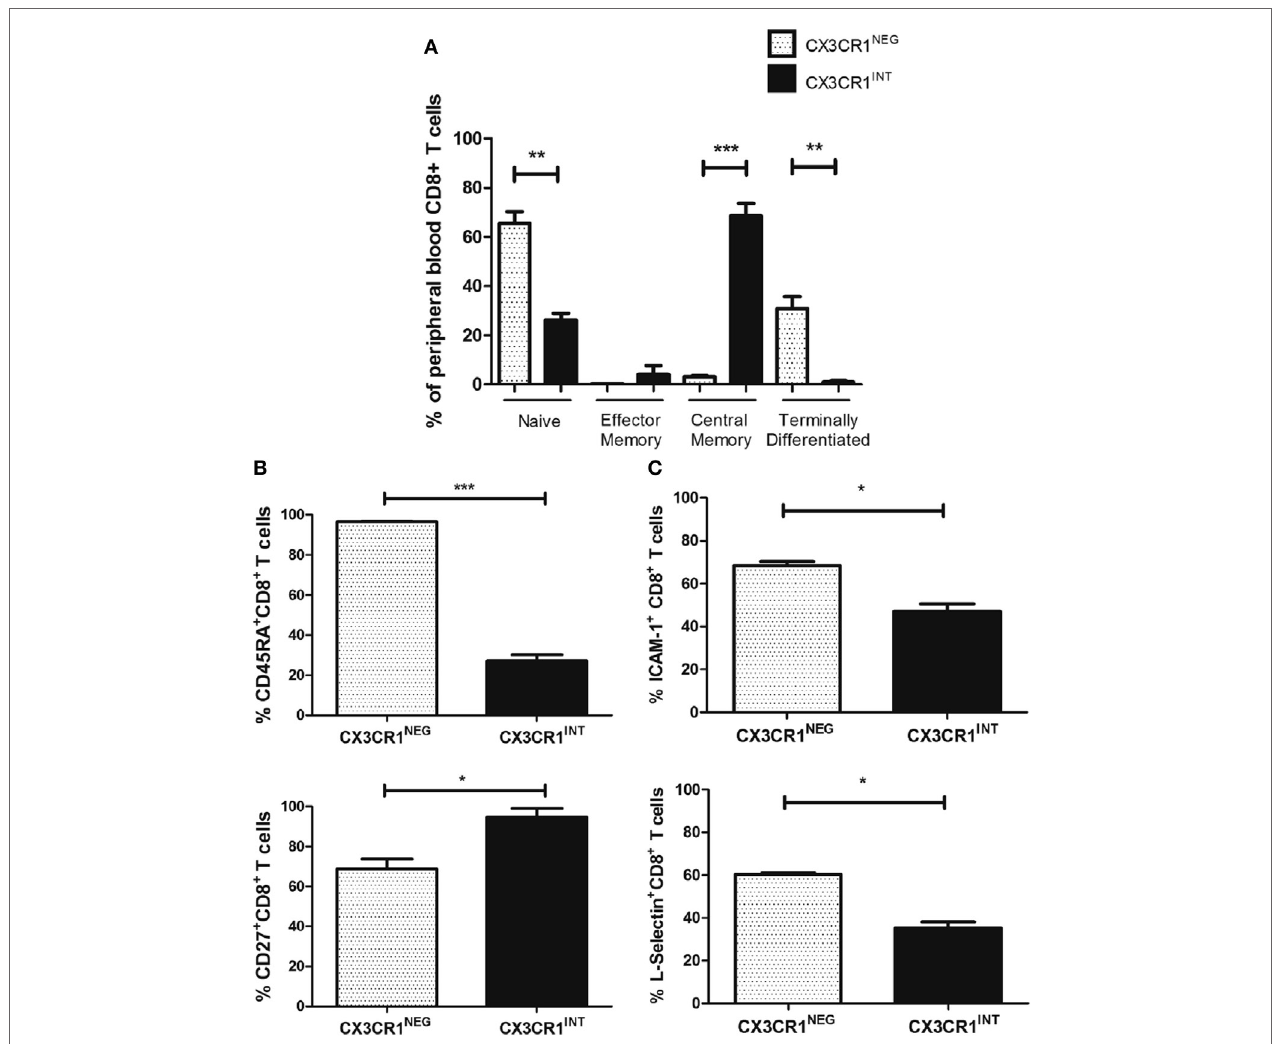
FigUre 5 | CX3CR1 NEG and CX3CR1 INT populations represent significantly different CD8 + T cells in the peripheral blood with significantly different memory phenotypes, L-selectin, and ICAM-1 expression. (a) Bar charts showing the frequencies of naive, central memory, effector memory, and terminally differentiated CD8 + T cells, characterized by CD45RA and CD27 expression within the CX3CR1 NEG and CX3CR1 INT populations in peripheral blood of six non-cancer controls. (B) Bar chart showing frequencies of peripheral blood-derived CD8 + T cells expressing CD45RA (top) and CD27 (bottom) within CX3CR1 NEG and CX3CR1 INT populations ( n = 3). (c) Bar chart showing frequencies of peripheral blood-derived CD8 + T cells ICAM-1 and L-selectin within CX3CR1 NEG and CX3CR1 INT populations ( n = 3). p < 0.05, ** p < 0.01, *** p < 0.001 by unpaired t